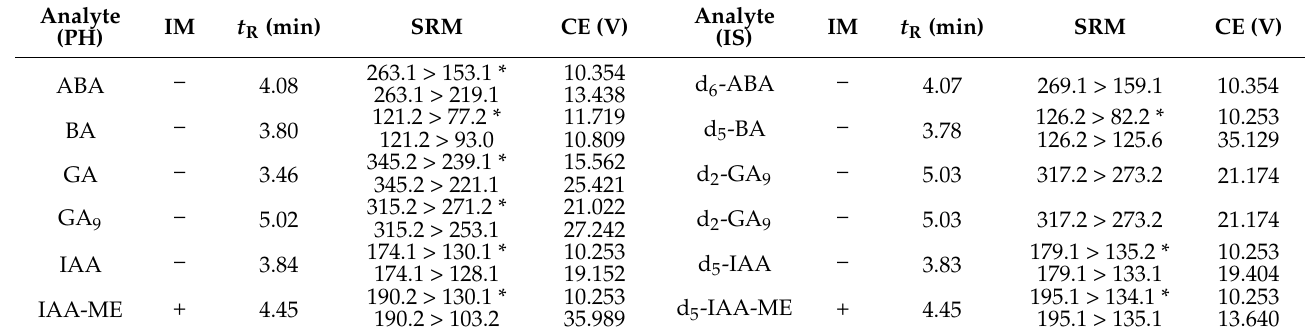
Table 1. Selected reaction monitoring (SRM) transitions of 14 target phytohormones (PH) and corresponding internal standards (IS) determined using a Thermo Scientific™ TSQ Endura system™. PH: phytohormone; IS: internal standard; IM: electrospray ionisation mode (ESI − or ESI+); t R : retention time (min); SRM: selected reaction monitoring (* indicates